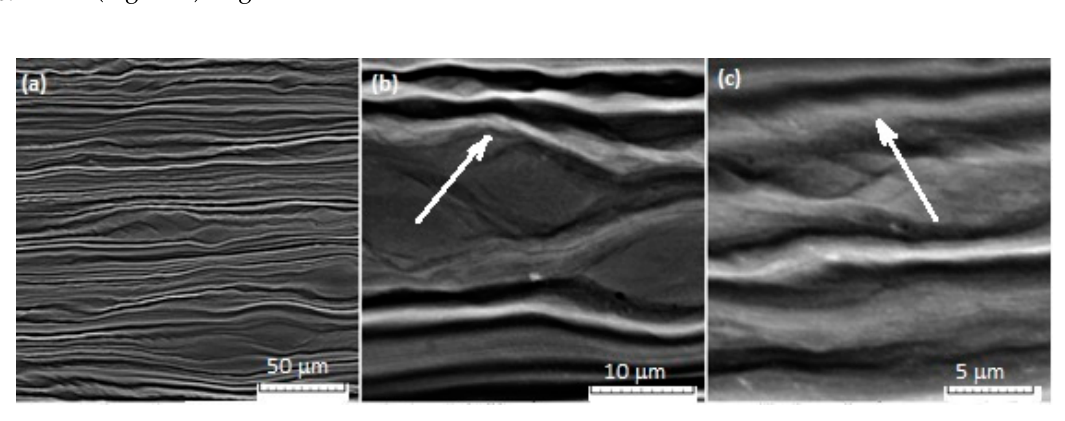
Figure 11. ( a – c ) SEM images of the sample processed by SPD-MPR ( ε tot = 60%) corresponding to the 2nd direction of the TMP Program ( a , b , c —same sample, with gradual increasing magnifications).